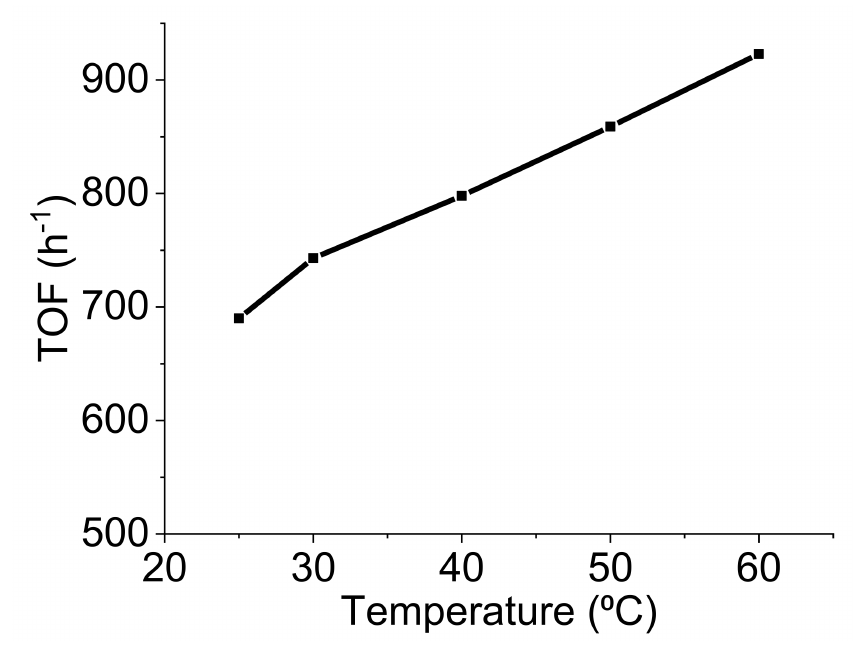
Figure 10. The temperature effect on TOF of FA degradation by